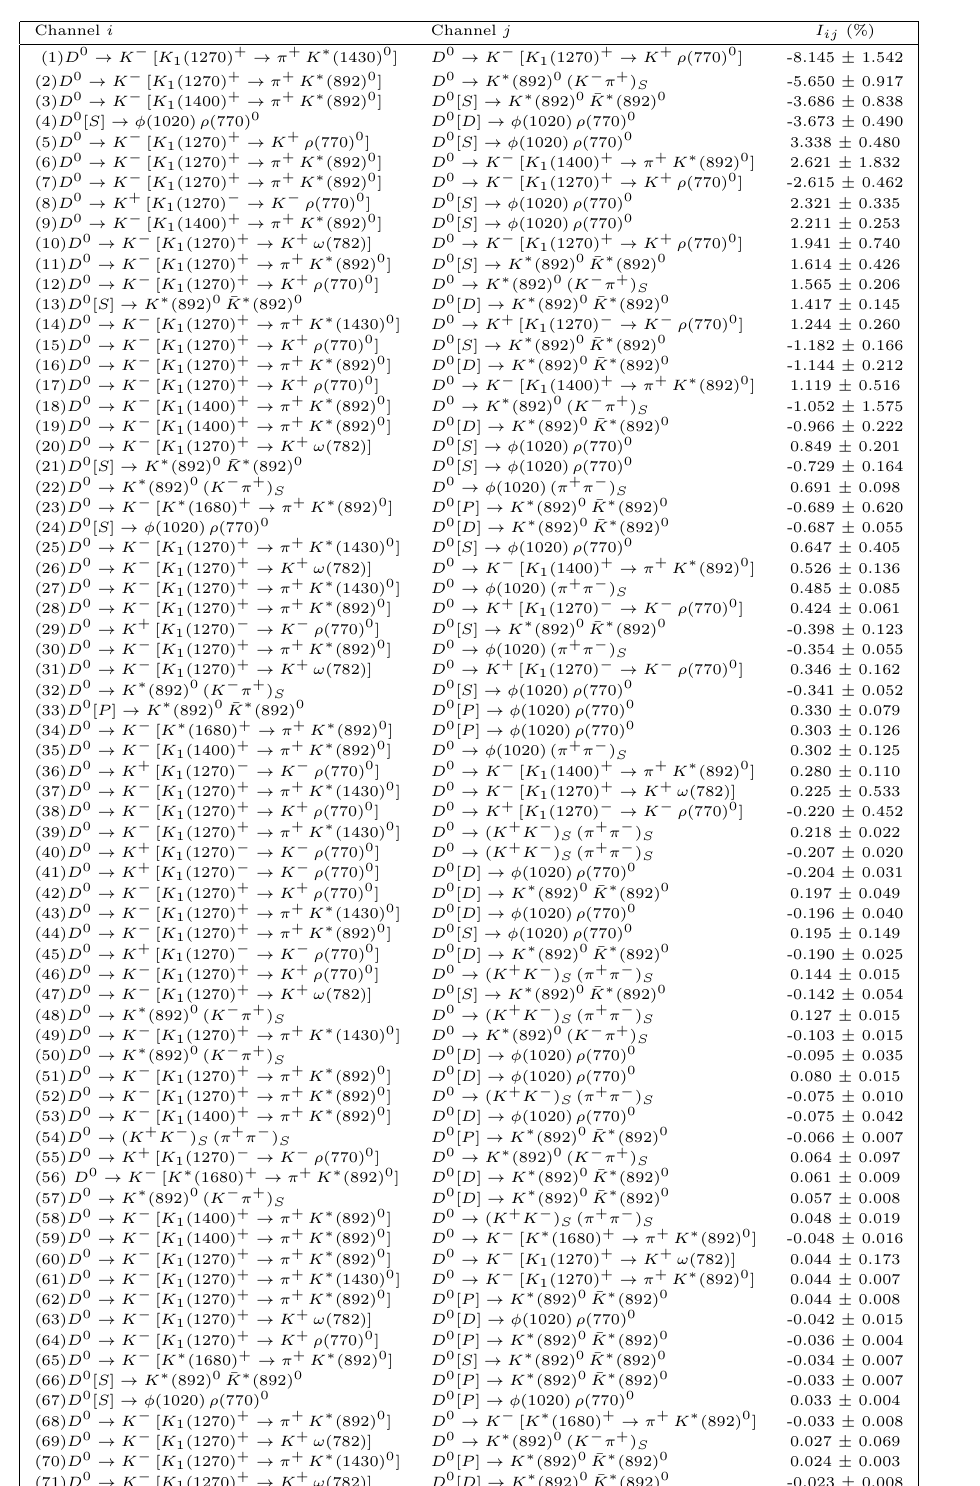
Table 23 . Interference fractions j I ij j > 0 : 02%, as de(cid:12)ned in eq. (4.27), ordered by magnitude, for the nominal D ! K + K (cid:0) (cid:25) + (cid:25) (cid:0) amplitude (cid:12)t. Only the statistical uncertainties are given.